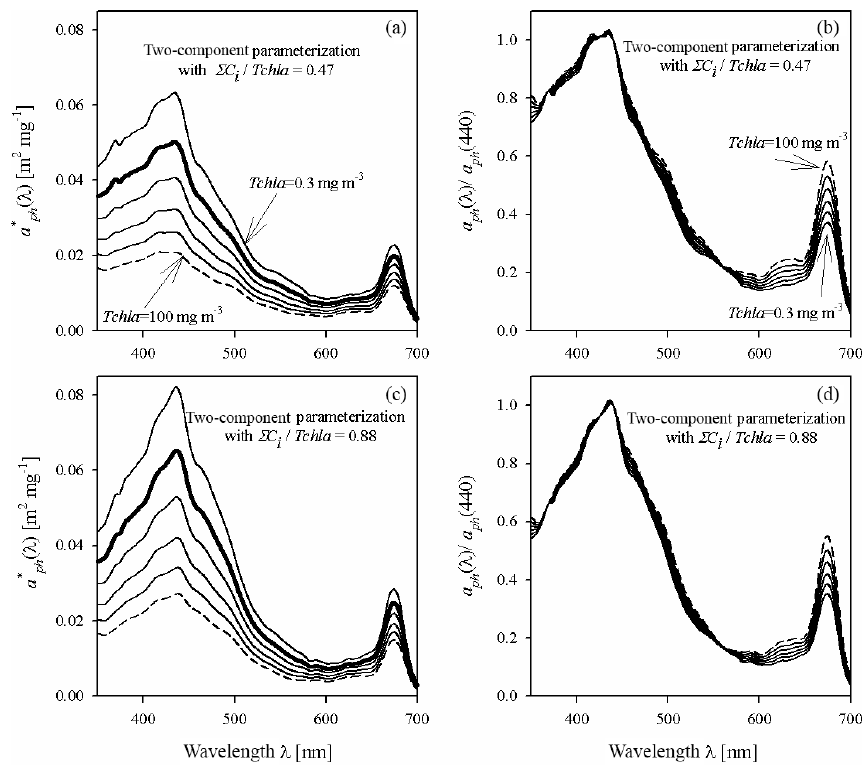
Figure 8. Example spectra of the specific coefficient of light absorption by phytoplankton a ∗ to its value in the 440nm band (b, d) , for some values of Tchl a between 0.3 and 100mgm − 3 , estimated by the two-component parameter- ization Eq. (4), and for two different assumed constant values of the pigment concentration ratio (cid:54)C i / Tchl a : 0.47 (representing the 10th percentile for all data) and 0.88 (representing the 90th percentile for all